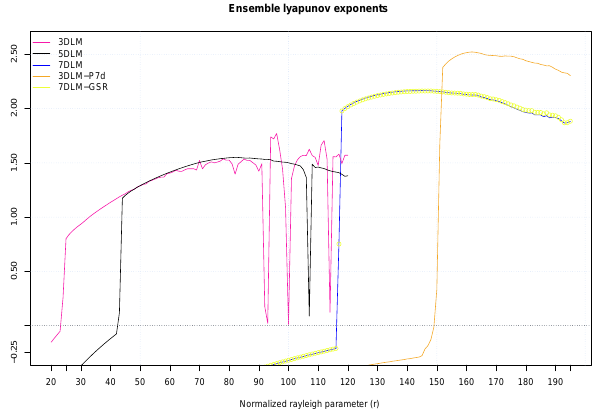
Figure 2. The largest ensemble-averaged Lyapunov expo- nents (eLEs) as a function of the forcing parameter, r , in different LMs. The figure provides results for (cid:49)r = 1. The pink, black, blue, and orange lines display eLEs for the 3DLM, 5DLM, 7DLM, and 3DLM-P7d, respectively, using the TS method. Open yellow cir- cles indicate the eLEs of the 7DLM using the GSR scheme. For the 7DLM, both methods yielded comparable results. The appear- ance of chaotic solutions is indicated by positive eLEs. Note that the critical value of r for the onset of chaos in the 7DLM is between r = 116 and r = 117. The pink and black lines are reproduced from Shen